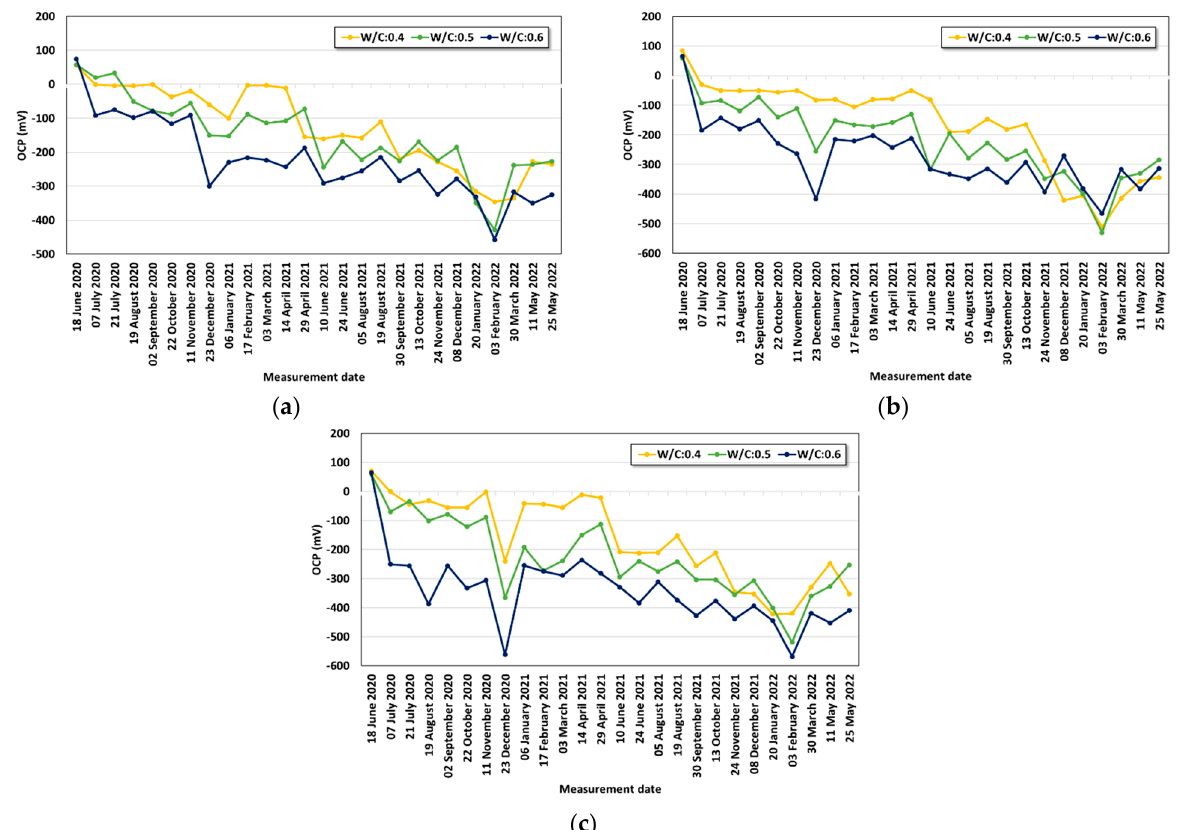
Figure 8. Open-circuit potential (OCP) evaluation under 3.5% chloride exposure conditions. Cover depths: ( a ) 60 mm, ( b ) 45 mm, and ( c ) 30 mm.